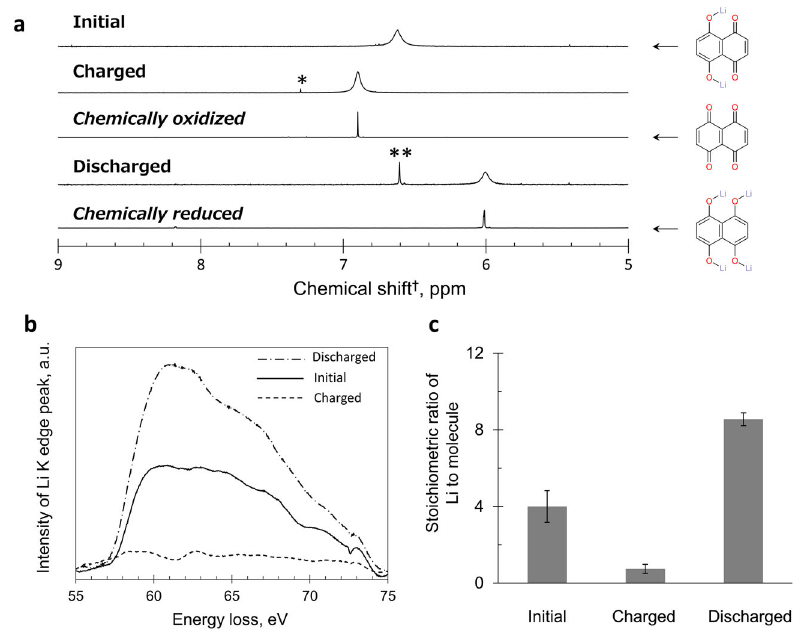
Fig. 7 Charge/discharge mechanism analysis of the electrodes using the naphthazarin monomer 1 and the dimer 2. a 1 H-NMR analysis for 1 during the charge/discharge processes. The signals with ‘ * ’ and ‘ ** ’ indicate the minor components of the partially reduced and oxidized states, naphthazarin hydroxy form and 1 , respectively. † The signal positions were calibrated with respect to those of 1 in DMSO- d 6 . b , c EELS spectra from the Li K -edge ( b ) and stoichiometric ratio of Li to 2 with standard deviation bars ( c